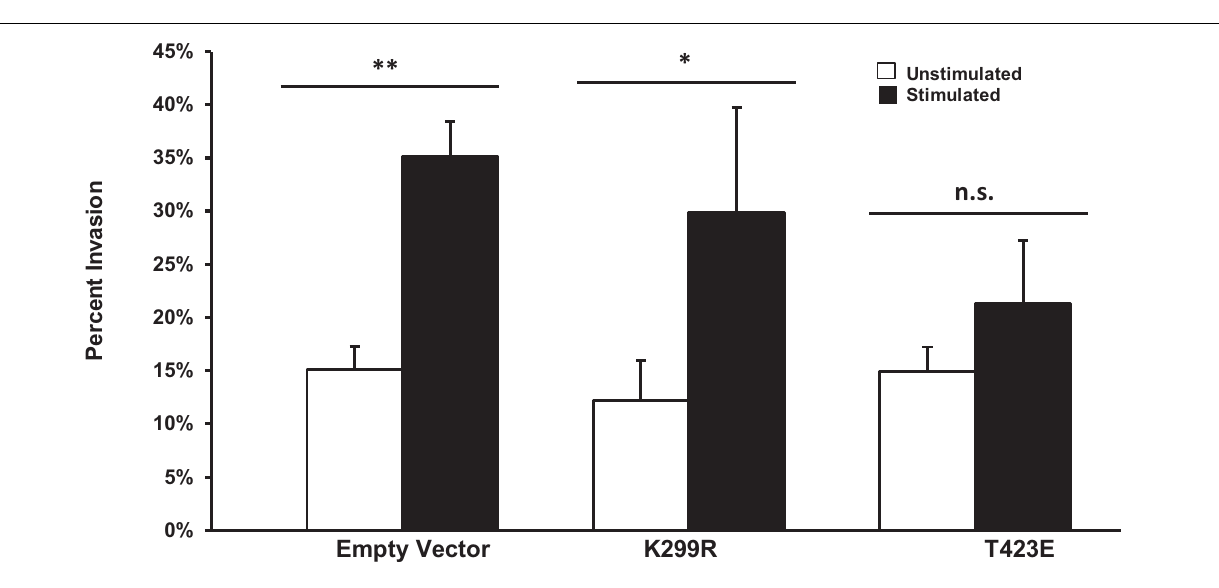
FIGURE 3 | Enhanced invasion in response to stimulation requires lower phosphorylation levels of PAK. In cells with PAK1 activity reduced (K299R), mechanical stimulation results in an enhanced level of cell invasion. When PAK1 activity is increased (T423E), stimulation no longer leads to more cell invasion. ∗ P < 0.05, ∗∗ P < 0.01 by Student’s t -test, data from at least three independent experiments. Error bars represent SEM ±